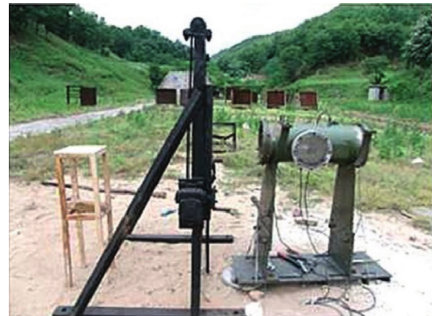
Figure 9: Experimental device in the field.